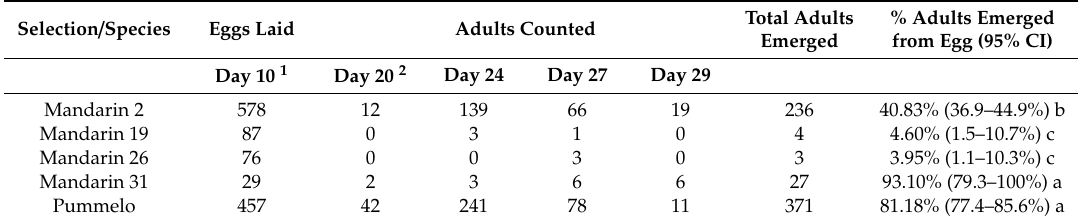
Table 5. Oviposition and survival of Diaphorina citri on four Mandarin selections and Pummelo. Selection / Species Eggs Laid Adults